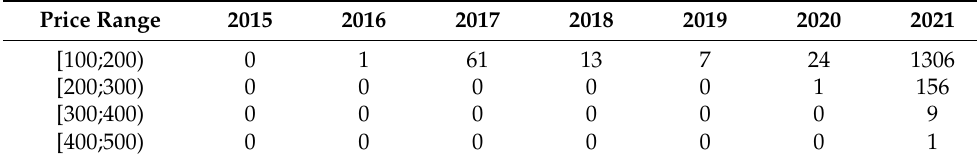
Table 1. Frequency of day-ahead prices above 100 EUR/MWh within the German/Luxembourg bidding zone (incl. Austria until 30 September